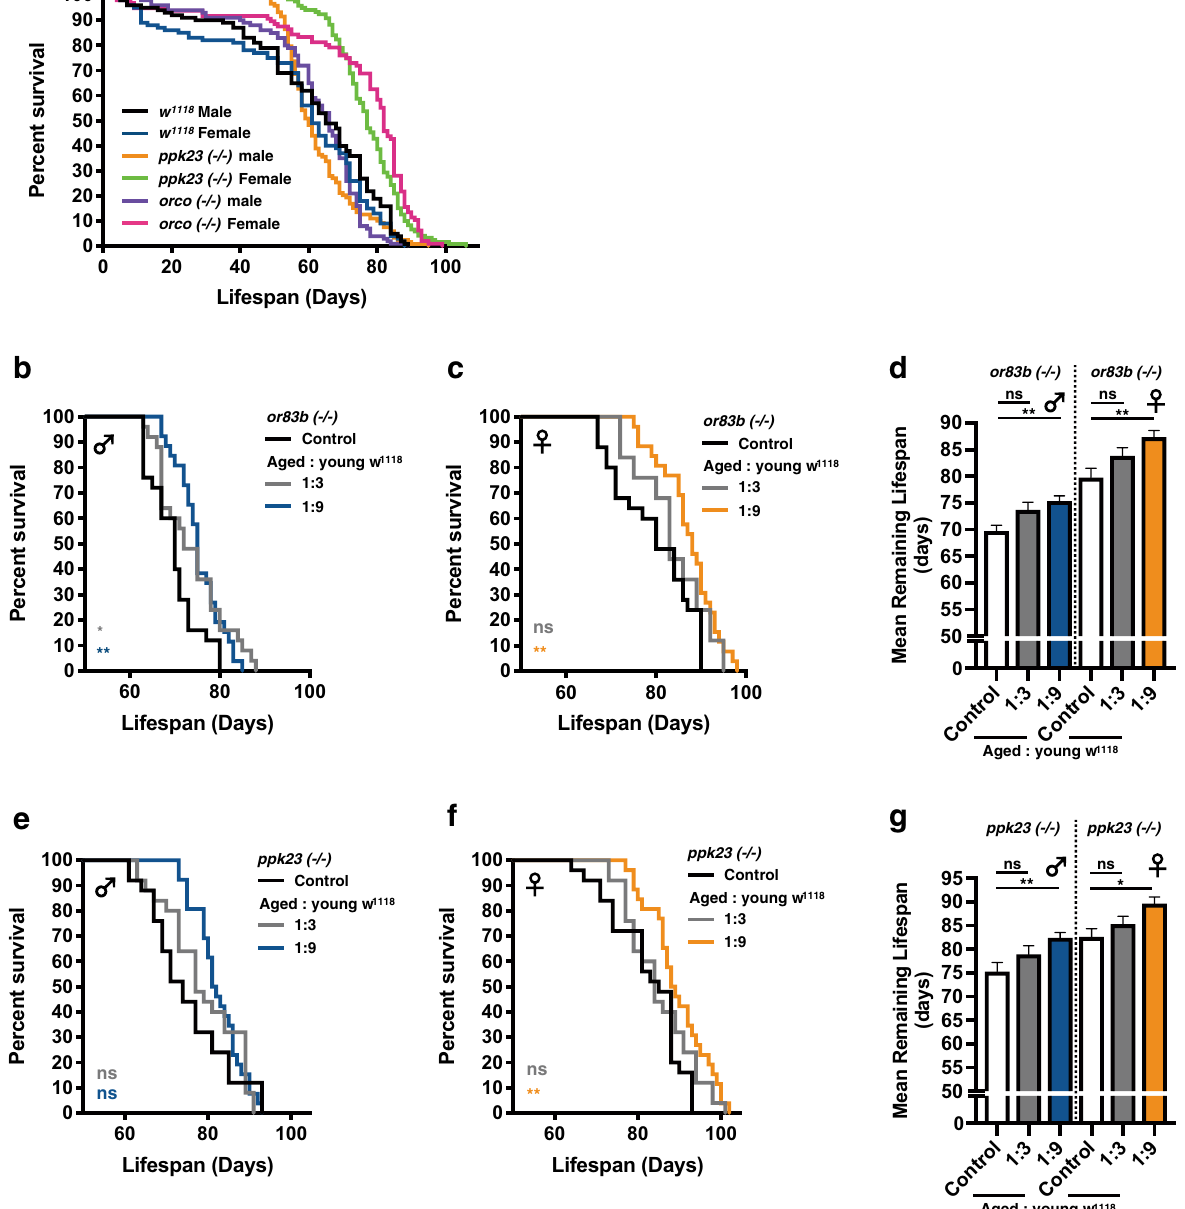
Fig. 5 Social perception of co-housed young fl ies by the aged fl ies involves the sensory inputs from olfaction and gustation. a Survival curves of the or83b( − / − ) , ppk23( − / − ) , and w 1118 control fl ies were shown. All fl ies were maintained at the density of 20 fl ies per vial. n = 96 – 119 in each genotype/gender. Lifespan results of aged or83b (b – d) or ppk23 (e – g) mutant fl ies co-housed with young w 1118 at the ratio of 1:3 and 1:9 (aged: young) were expressed as survival curves and means ± SEM. P values: ns > 0.1234; <0.0332*; <0.0021**. P values of the columns were annotated by the Kruskal – Wallis test and followed by Dunn ’ s multiple comparison test and survival curves were annotated by the Log-rank (Mantel-Cox) test. Sample size: (1) n = 25 for the control fl ies, samples were randomly collected from 3 independent experimental sets, (2) n = 25 for the co-housing experiments performed at 1:3 ratio; results were collected from 5 independent experimental sets, (3) n = 26 for the co-housing experiments performed at 1:9 ratio; results were collected from 13 independent experimental